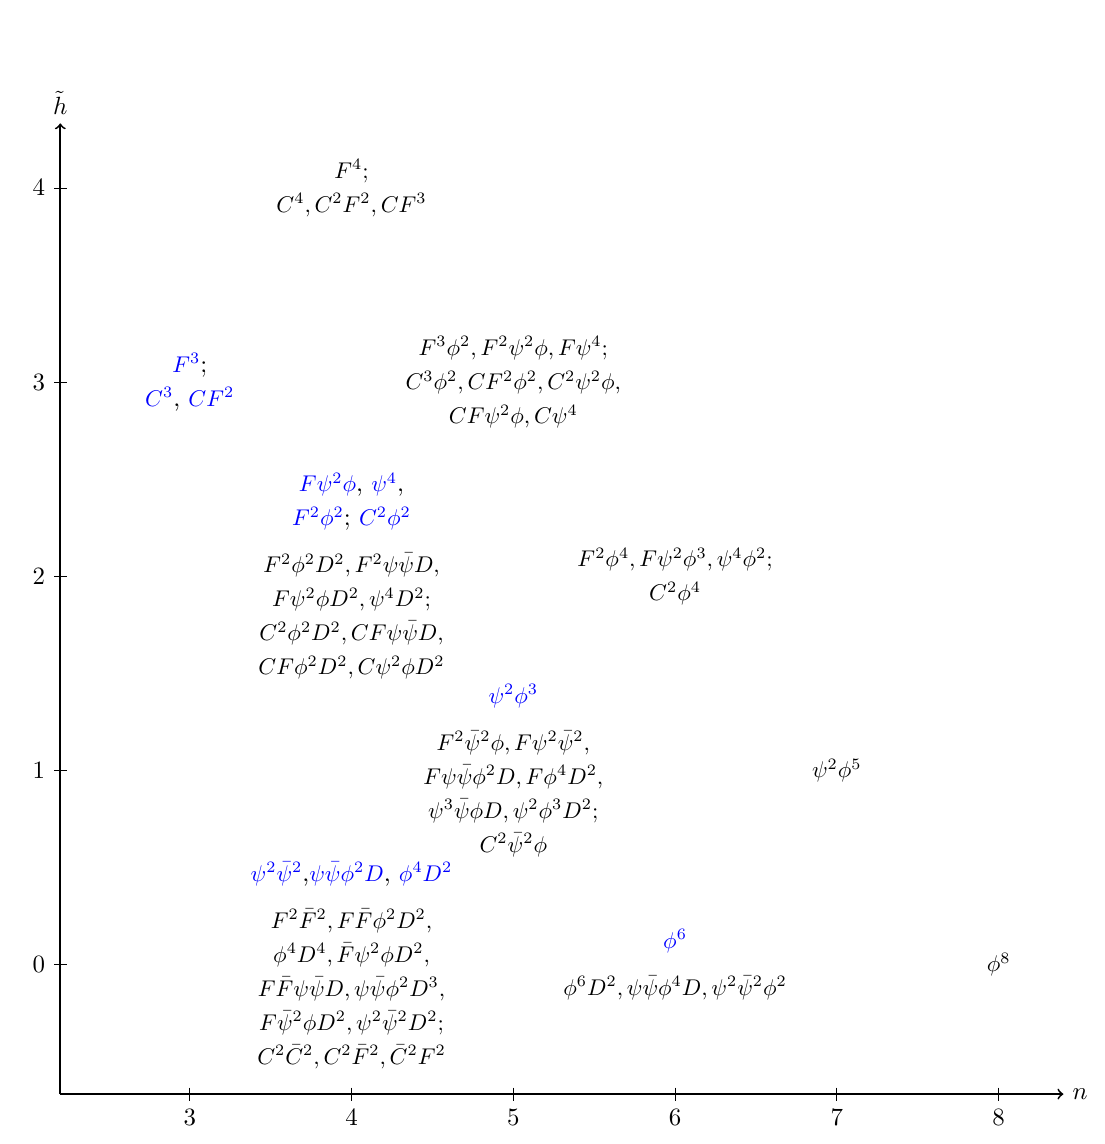
Figure 9 . Classes of independent dimension-six (blue) and -eight (black) operators in the GRSMEFT labeled according to the modified helicity and number of external particles of the minimal amplitude they induce. The non-renormalization theorem in eq. (3.7) implies that a Wilson coefficient C j can only renormalize a C i that lies inside the cone ˜ h i ≤ ˜ h j ± ( n i − n j ) . This holds irrespectively of the considered operator dimensions and also allows mixing into higher-dimensional operators according to the power counting rule in eq.